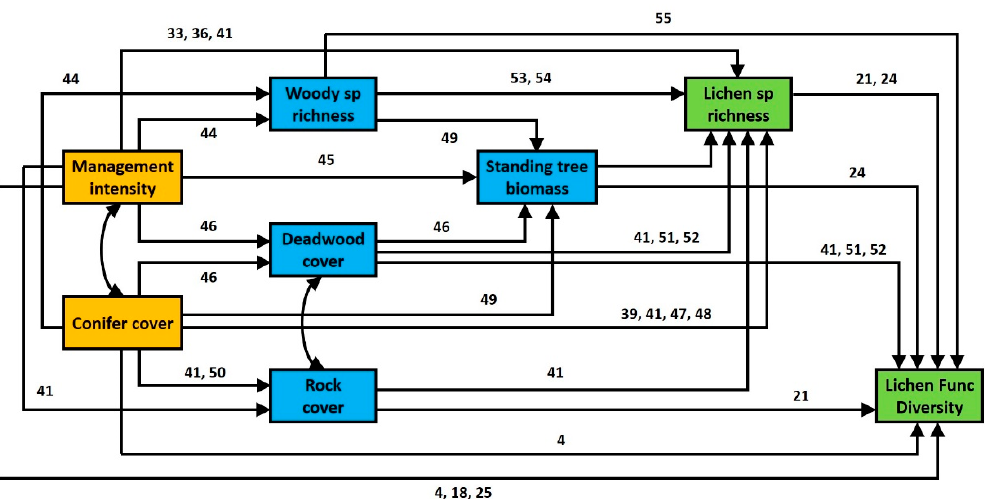
Figure 1. Theoretical model for the effects of forest management and conifer cover (orange boxes) on environmental variables (blue boxes) and lichen biodiversity (green boxes). Single-headed arrows indicate a direct effect of a given variable on another. Double-headed arrows indicate a mutual dependency between two variables. The numbers next to each arrow indicate references supporting the presence of that direct effect [4,18,21,24,25,33,36,39,41,44–55].